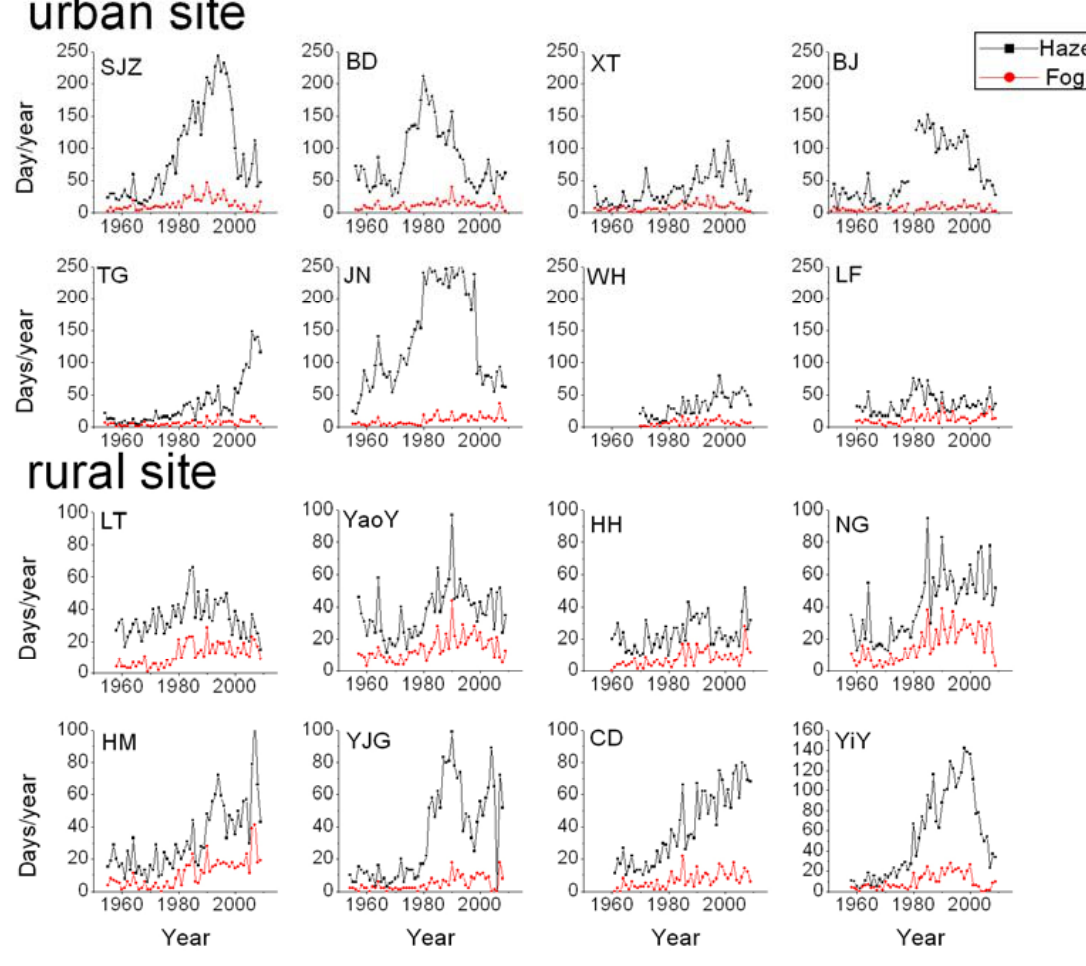
Fig. 2. The occurrences of haze (black lines) and fog (red lines) over NCP during